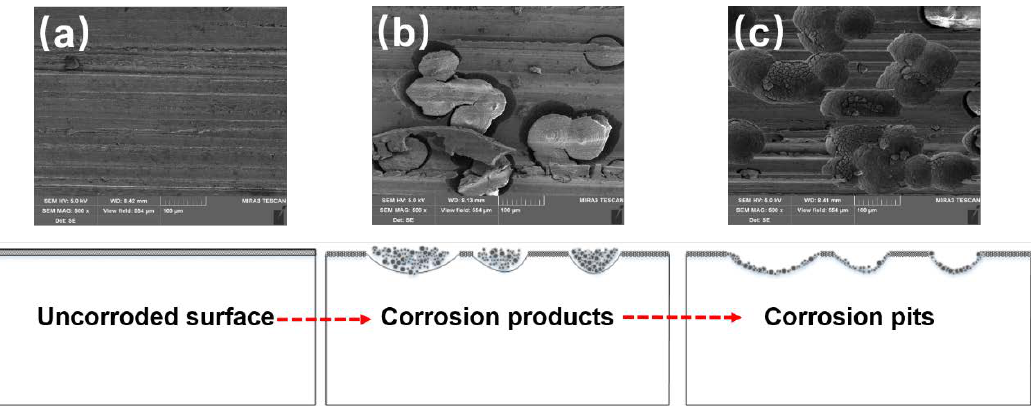
Figure 11. Schematic of the electrochemical dissolution behavior of Inconel 718 ground by robotic belt grinding system: ( a ) Uncorroded surface, ( b ) Corrosion products, ( b ) Corrosion pits.